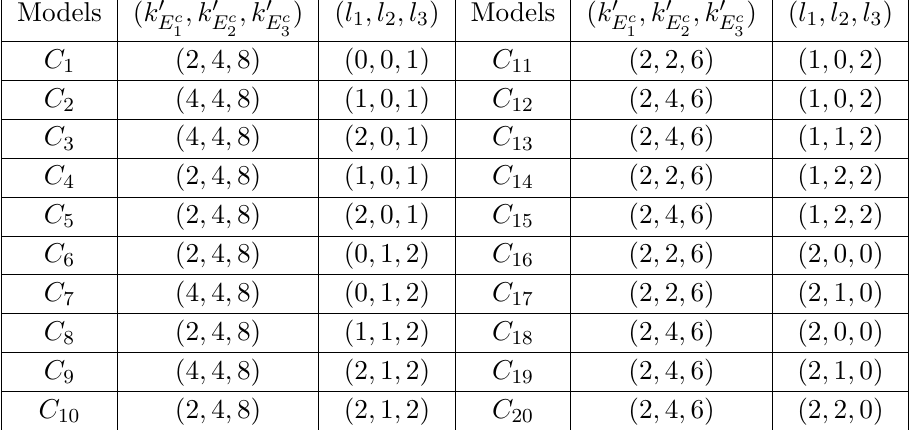
+ k is the modular ≡ k E c L E c i i with 1 0 ≡ 1 , 1 1 ≡ 1 0 and 1 2 ≡ 1 00 . 4